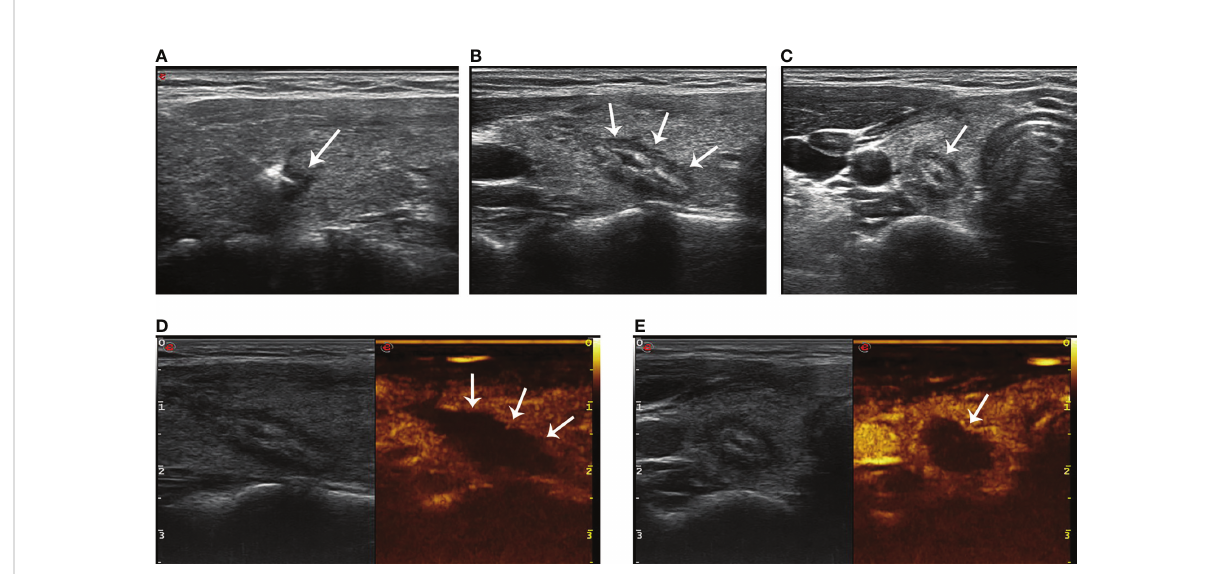
FIGURE 3 The hyperechoic area (arrow in A ) around the pointed end of the optical fi ber during PLA. The lesion (arrow in B , longitudinal plane; arrow in C , transverse plane) shows medium – high echogenicity in the ablation area and hypoecho in the surrounding area, with a clear boundary between the ablation area and normal tissue 24 h after ablation. There was no contrast agent perfusion in the ablation area (arrow in D , longitudinal plane; arrow in E , transverse plane) after PLA 24 h on